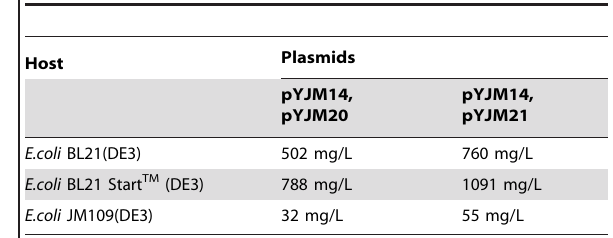
Table 2. Isoprene production by different E. coli strains harboring pYJM14 and pYJM20 or pYJM14 and pYJM21 under flask